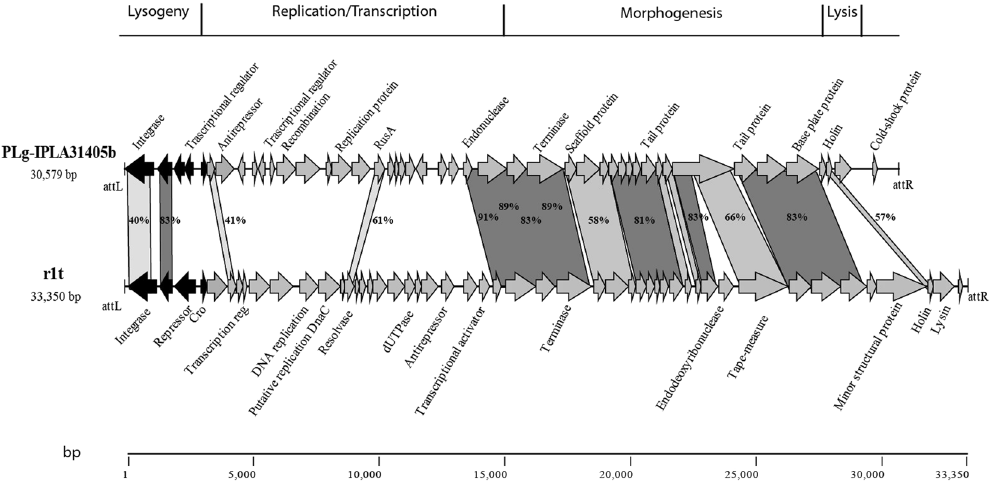
Figure 5. Genomic comparison between L. garvieae phage IPLA31405b and L. lactis phage r1t. Color shading was used to discriminate between ≥ 70% amino acid identity (dark color) and ≤ 69% amino acid identity (light color). The absence of shading means no significant similarity. The percent of amino acid identity inside the shading is representative of the aligned region only. Black arrows identify the lysogeny